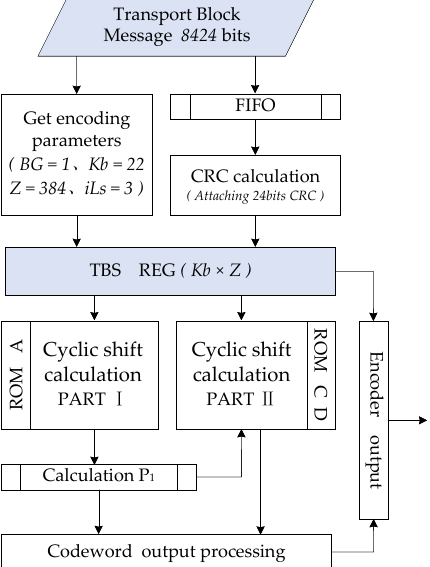
Figure 7. Encoder operation flow